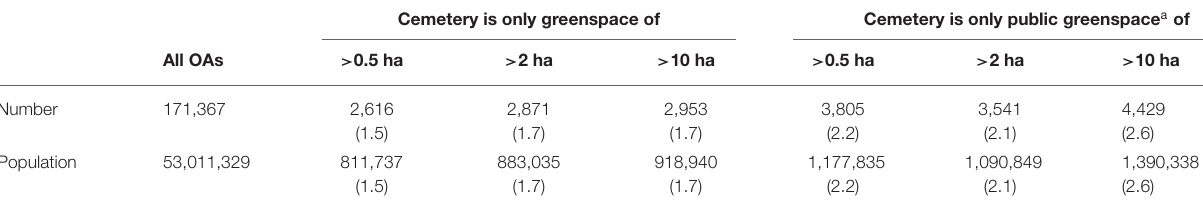
TABLE 4 | Number (percentage) of output areas ( n = 171,367) and population (percentage; n = 53,011,329) in England with cemeteries as the only accessible greenspace. Cemetery is only greenspace of